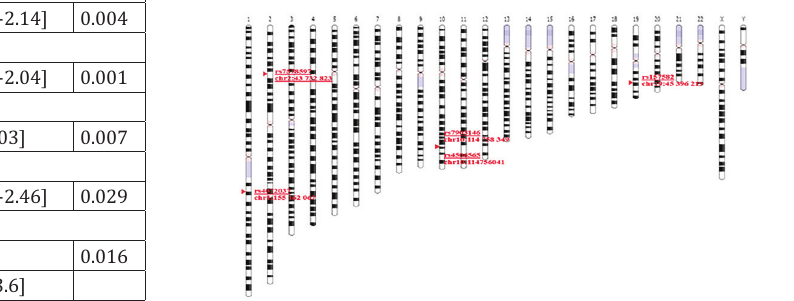
Figure 3 - Location of polymorphisms in chromosomes that influence the development